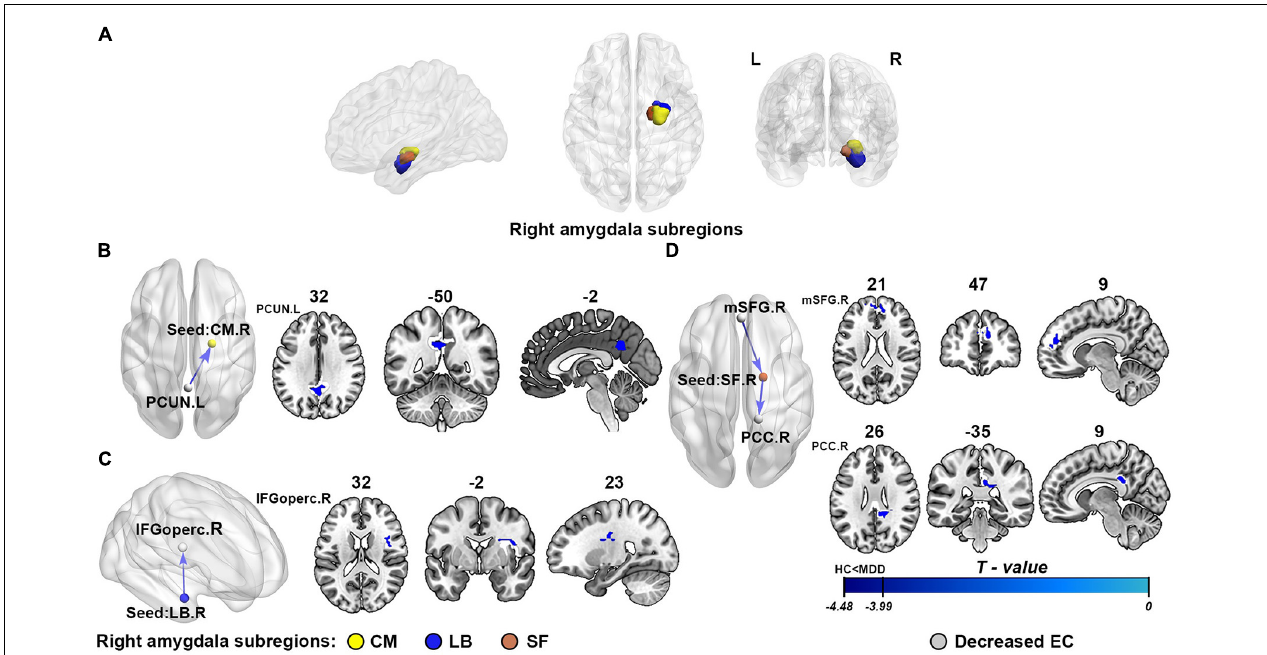
FIGURE 2 | The results of effective connectivity analysis of right amygdala subregions. (A) The subregions of the right amygdala: the centromedial amygdala (CM; yellow), laterobasal amygdala (LB; purple), and superficial amygdala (SF; red). (B–D) Represent the illustration of the abnormal effective connectivity of MDD in three different right amygdala subregions, respectively: CM, LB, and SF. The cool color arrows indicate significant decreased information flow of target brain regions in MDD. The gray indicates the specific abnormal brain regions, and the yellow/purple/red represents right CM/LB/SF, respectively. EC, effective connectivity; CM, centromedial amygdala; LB, basolateral amygdala; SF, superficial amygdala; PCUN, precuneus; IFGoperc, opercular part of inferior frontal gyrus; mSFG, medial superior frontal gyrus; PCC, posterior cingulate cortex; L, left hemisphere; R, right